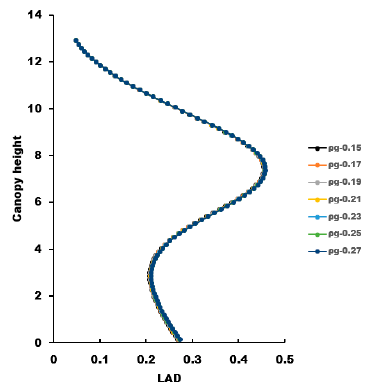
Figure 16. An example of a LAD profile derived from GLAS data with different values of ρ g .